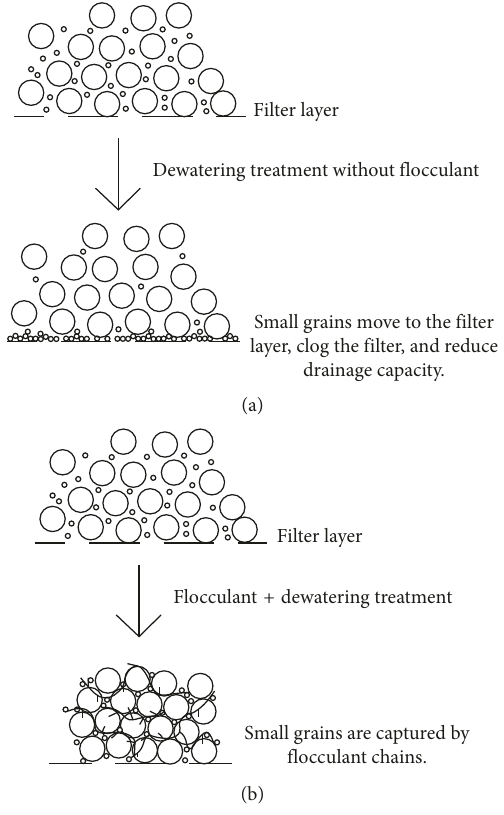
Small grains are captured by flocculant Figure 12: Proposed mechanism of flocculant-aided dewatering in vacuum preloading and geotextile tube. (a) Dewatering without flocculant addition. (b) Dewatering with flocculant addition.